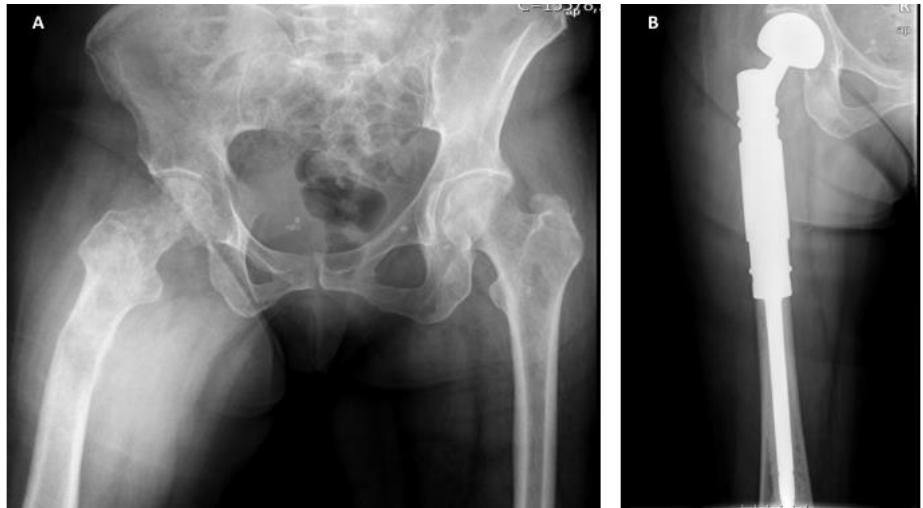
Figure 3. Extensive breast cancer bone metastasis in a female patient with multimetastatic bone disease: ( A ) anteroposterior pelvic radiograph showing a pathologic fracture in the right femur, not amenable for reconstruction due to extension of the metastatic bone disease, ( B ) immediate postoperative radiograph showing anteroposterior view of the right femur with a bipolar tumoral hip megaprosthesis, used to provide stability and pain relief. After surgery, the patient underwent local radiotherapy and bone-targeted